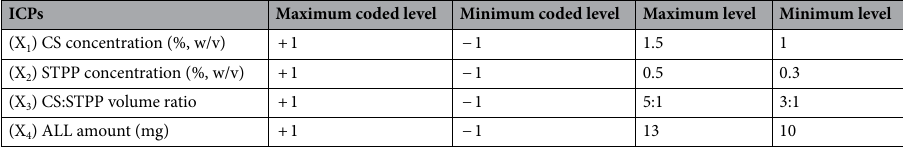
where Y: DMP, β o : the arithmetical mean response of the 16 runs, β 1 , β 2 , β 3 , and β 4 : linear coefficients, β 5 , β 6 , β 7 , β 8 , β 9 and β 10 : interaction coefficients between the two ICPs, β 11 , β 12 , β 13 , and β 14 : interaction coefficients between the three ICPs, Β 15 : interaction coefficient between the four ICPs, X 1 , X 2 , X 3 and X 4 : ICPs. Preparation of ALL‑loaded CS/STPP NPs. The ionotropic gelation method was followed in the prepa- ration of ALL-loaded CS/STPP NPs, as previously described, which relies on the basis of an ionic interaction between the primary amino group of CS solution (positively-charged) and the phosphate group of STPP solution (negatively-charged) 18 . In brief, low MW CS (1 or 1.5% (w/v)) was dissolved in (1% v/v) aqueous acetic acid solu- tion and magnetically stirred using magnetic stirrers (MS300HS, MTOPS Corp., Korea) until complete dissolu- tion. CS’s solution pH was elevated to 6 using 1 N NaOH, where such pH value maintains CS in its soluble form at the inspected concentrations 19 . Next, STPP aqueous solution was prepared at two different concentrations (0.3 or 0.5% (w/v)). Both CS as well as STPP solutions were filtered through a 0.45 μm pore size filter (EMD